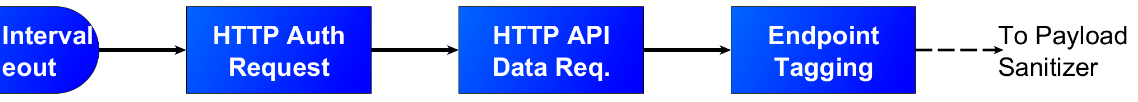
Figure A1. HTTP interval polling-based data ingest step for device data integration.